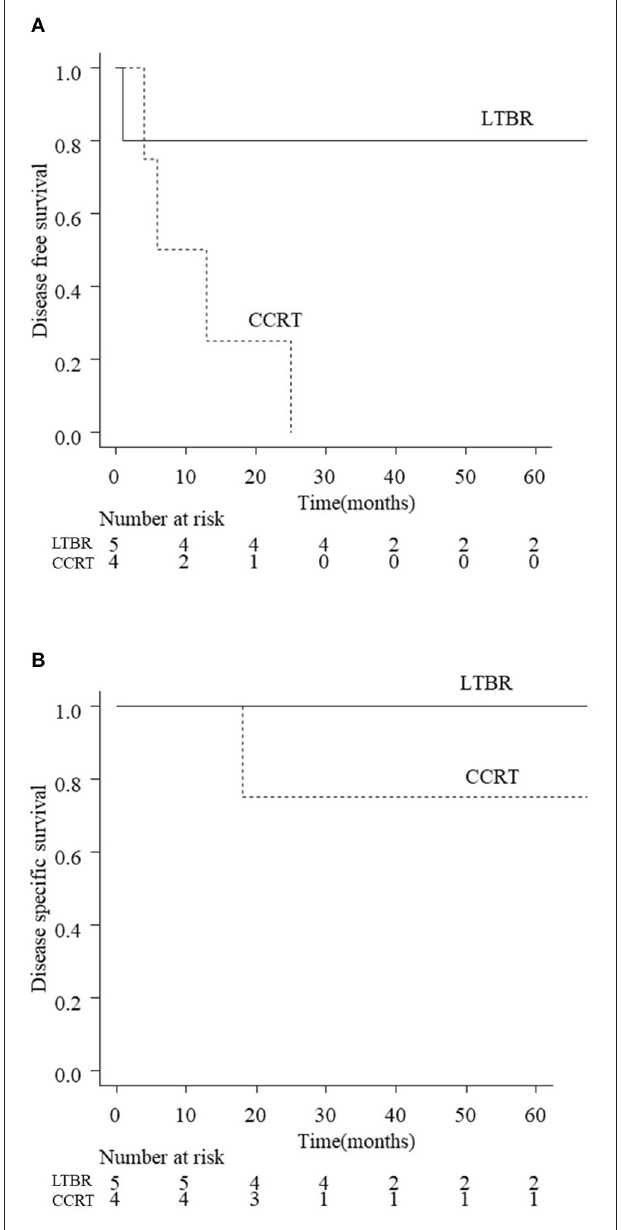
FIGURE 2 | Disease free survival (DFS; A ) and disease specific survival (DSS; B ) of EAC carcinoma patients according to the disease stage. The estimated 3-year DFS rate of all patients was 77.4% in stage 1, 100% in stage 2, 44.4% in stage 3, and 11.1% in stage 4 ( p < 0.01). The estimated 3-year DSS rate of all patients was 100% in stages 1 and 2, 87.5% in stage 3, and 11.1% in stage 4 ( p < 0.01).